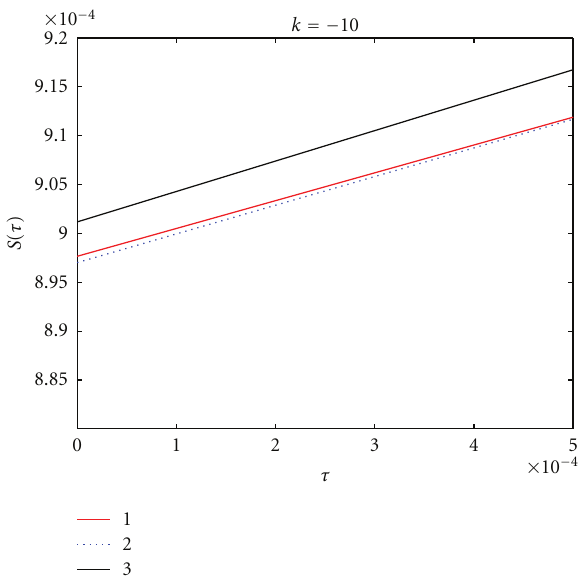
Figure 8: The relationship of similarity function S ( τ ) and τ under k = − 1 . 2 . Curve 1 is with our increased system (5) when m = 112 . Curve 2 is with the system (4) when h (cid:2) = h , φ (cid:2) = 0 , curve 3 is in the case of φ (cid:2) = 0 . 1 , curve 4 is in the case of φ (cid:2) = 0 . 5 , and curve 5 is in the case of φ (cid:2) = 1 .